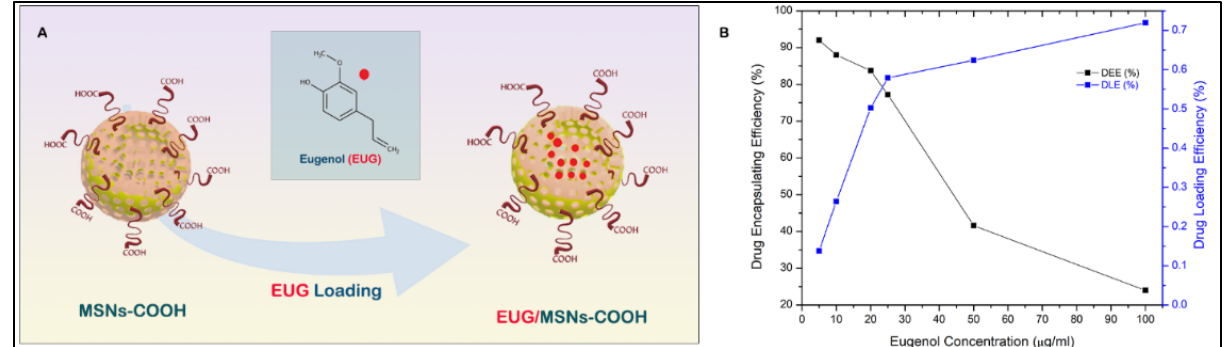
Figure 7. ( A ) Eugenol EUG loading into the MSN pore channels, ( B ) Effect of EUG concentration on drug loading efficiency (DLE) and drug encapsulation efficiency (DEE) of MSN nanoassemblies, 25 µg/mL EUG concentration was identified as the optimum concentration that was efficiently loaded to the MSN channels.